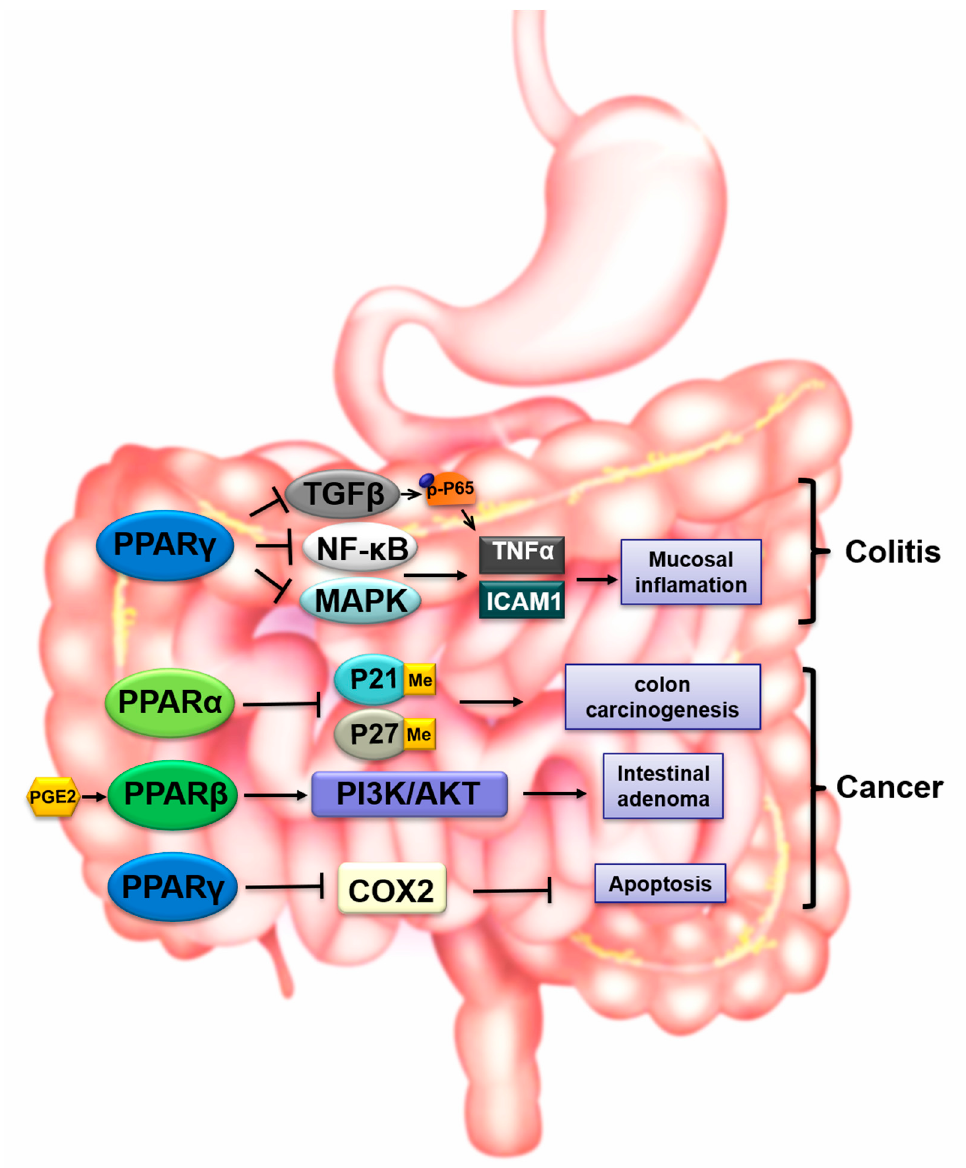
Figure 2. The regulation by PPARs in gastrointestinal toxicity.